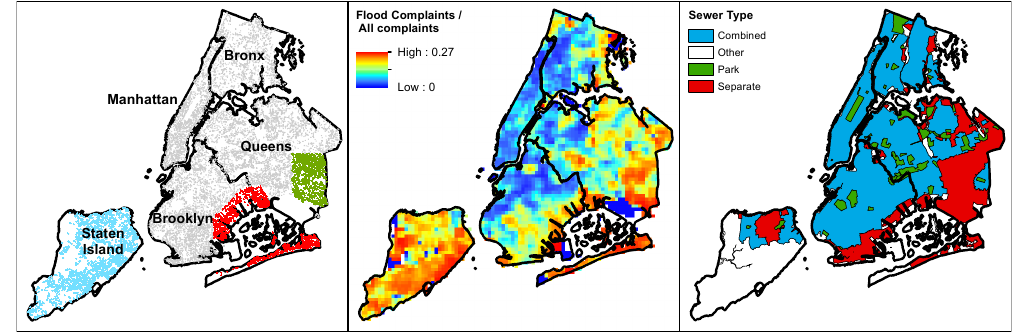
Figure 2. Flood observations through 311 for the period 2004–2015. Left panel : Each point represents one 311 flood observation. Blue points are in Staten Island, red points are near Jamaica Bay, and green points are in southeast Queens; Center panel : Flood observations through 311, normalized by all 311 observations. Units are in flood observations per any observation in 1 km 2 ; Right panel : New York City (NYC) sewer type.